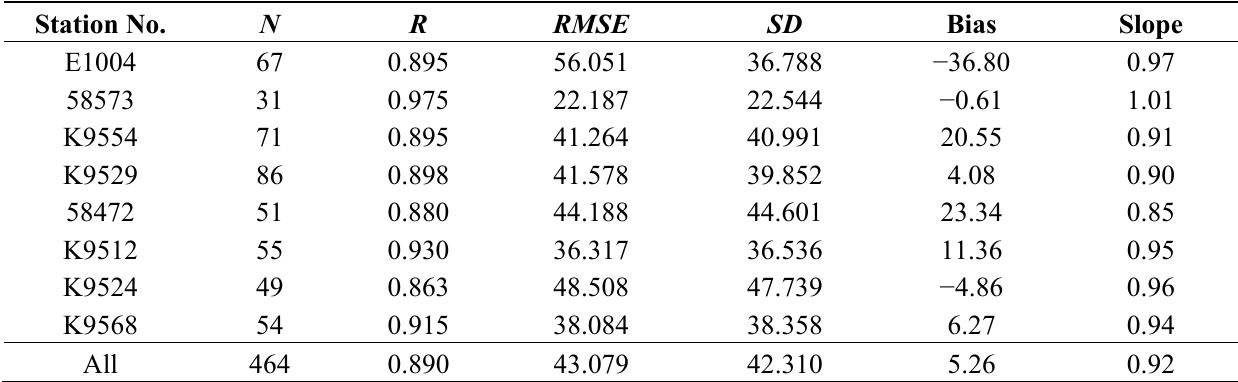
Table 4. The same as Table 3, but for wind